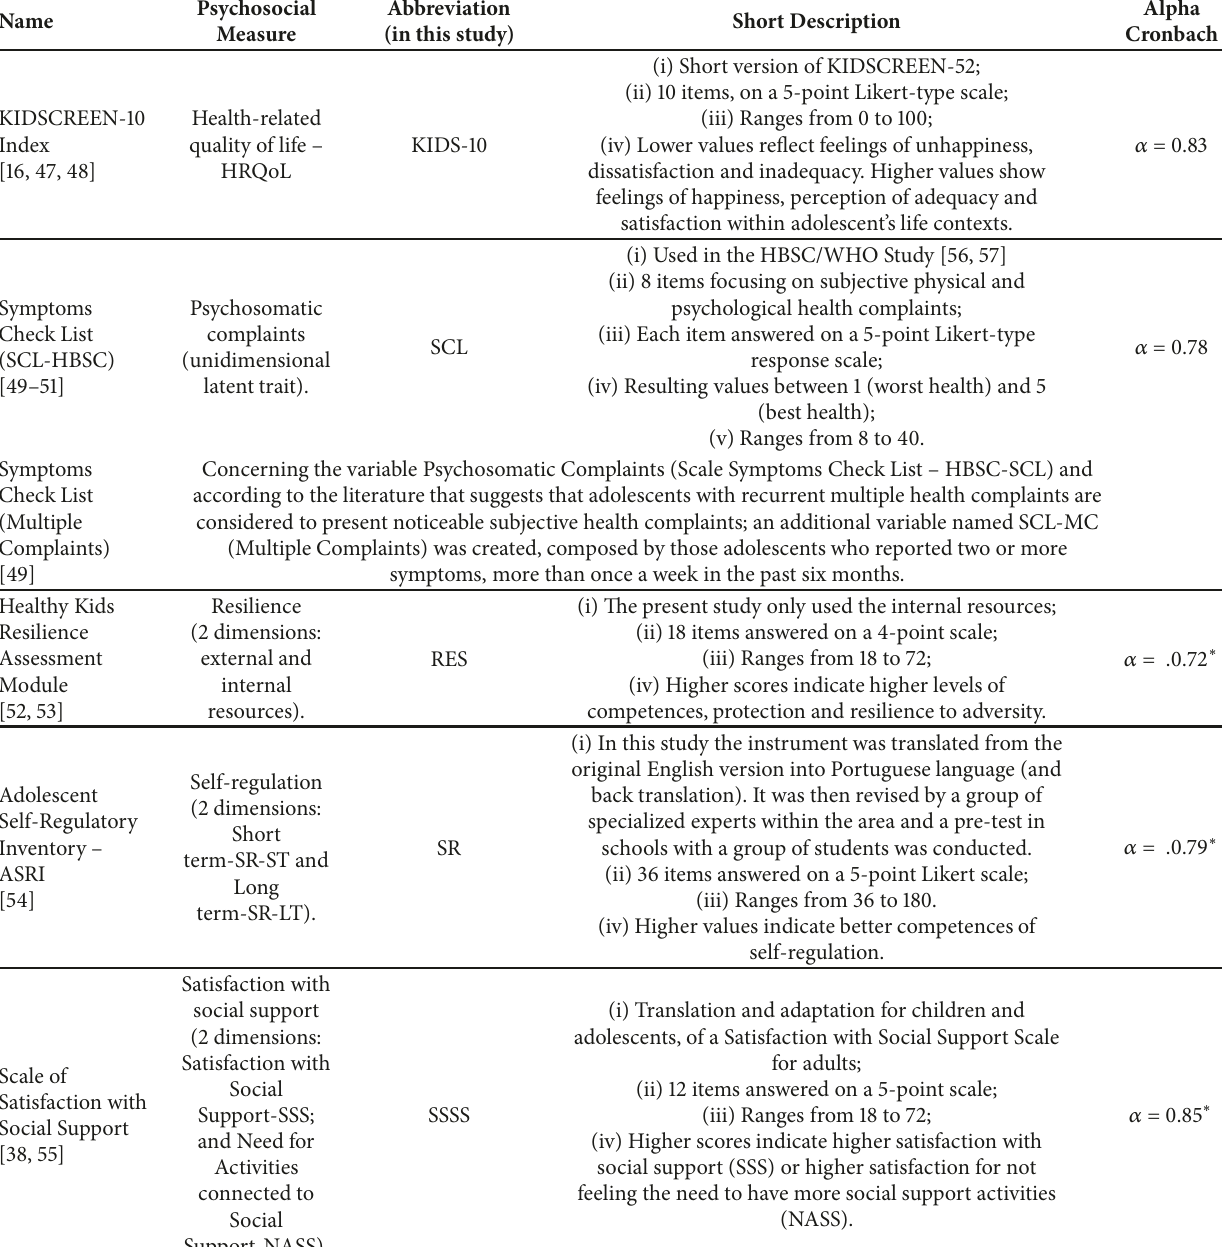
Table 1: Psychosocial